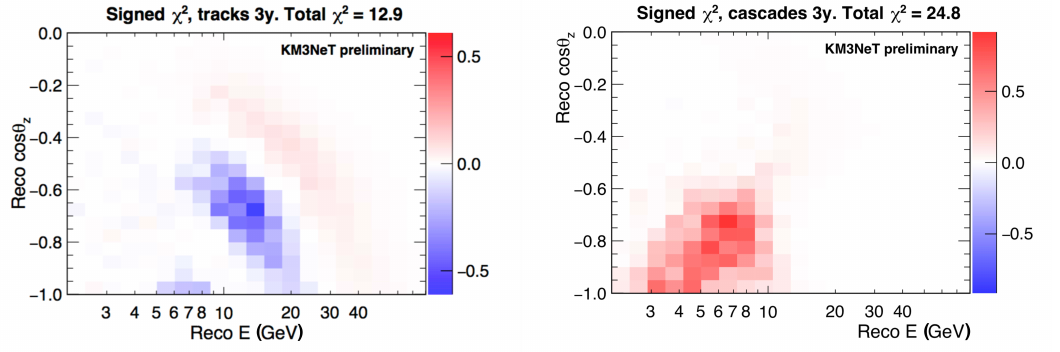
Figure 7. Signed χ 2 as a function of the reconstructed (RECO) neutrino energy and cosine zenith for track-like events ( left ) and cascade-like events ( right ).